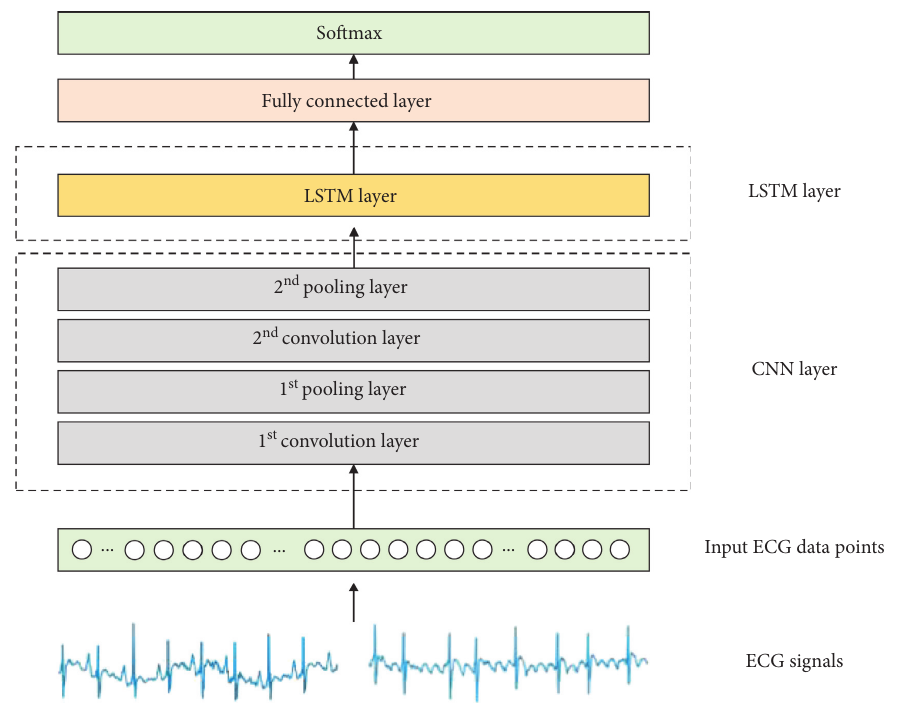
Figure 6: CNN-LSTM network structure. Table 1: The parameters of the model.